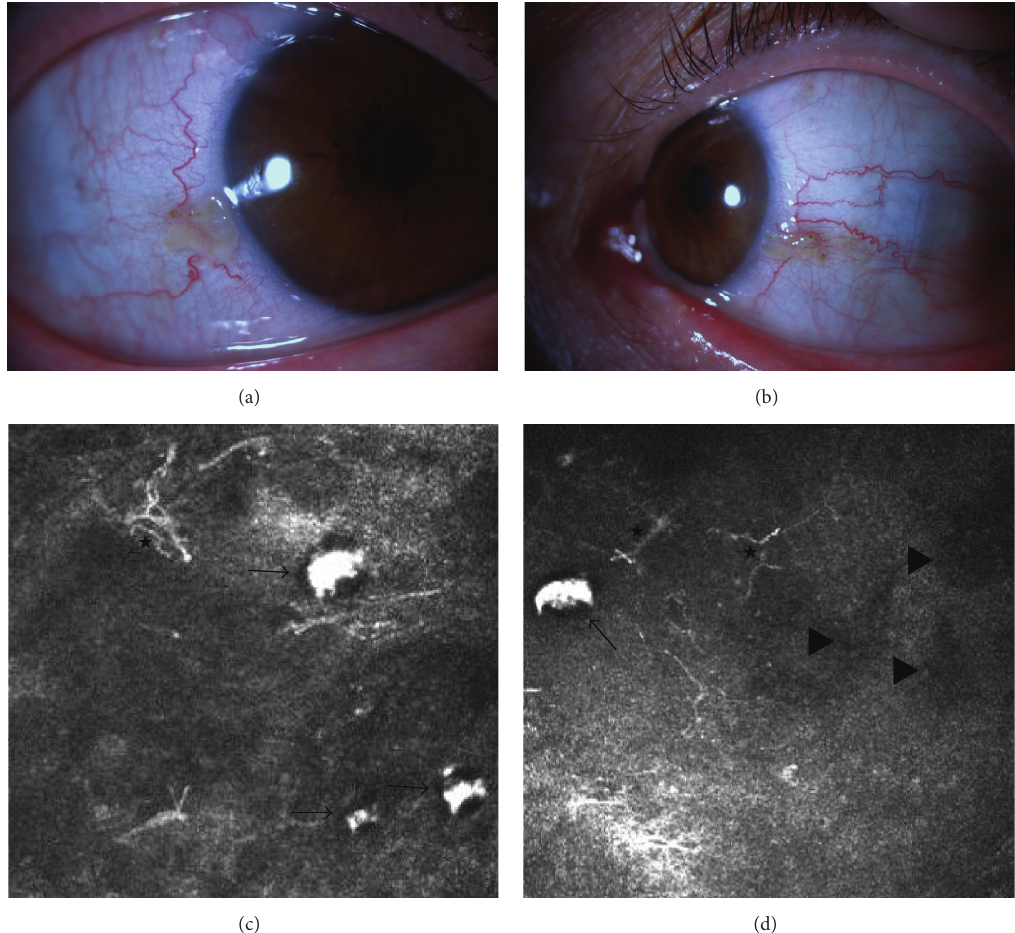
Figure 3: Anterior segment photos and in vivo confocal microscopic images of Case 2, 400×400 𝜇 m. (a) Right eye temporal conjunctiva. (b) Left eye temporal conjunctiva. (c) Hyperreflective deposits presumed to be homogentisic acid accumulation beneath conjunctival epithelium (black arrows) and dendritic cells (star). (d) Hyperreflective homogentisic acid deposit (arrow) and hyporeflective areas (arrow head) in the conjunctiva close to